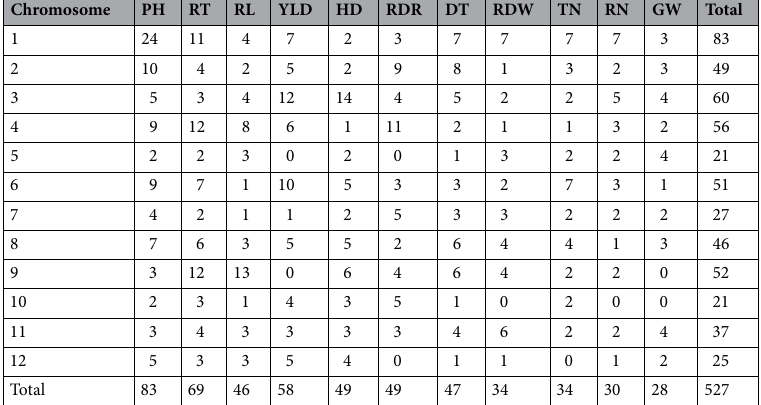
for YLD (MQTL-YLD3) on chromosome 3 (Fig. 3; Additional file 2). The MQTL analysis considerably narrowed the CI allowing for exploration of a reduced number of candidate genes (CGs) for the investigated traits. The average CI was reduced from 15.57 cM in the initial QTLs to 5.48 cM in the MQTL with 65% of MQTLs having CI < 5 cM (Table 3). In 10 MQTLs, MQTL-GW4, HD4, HD7, PH3,